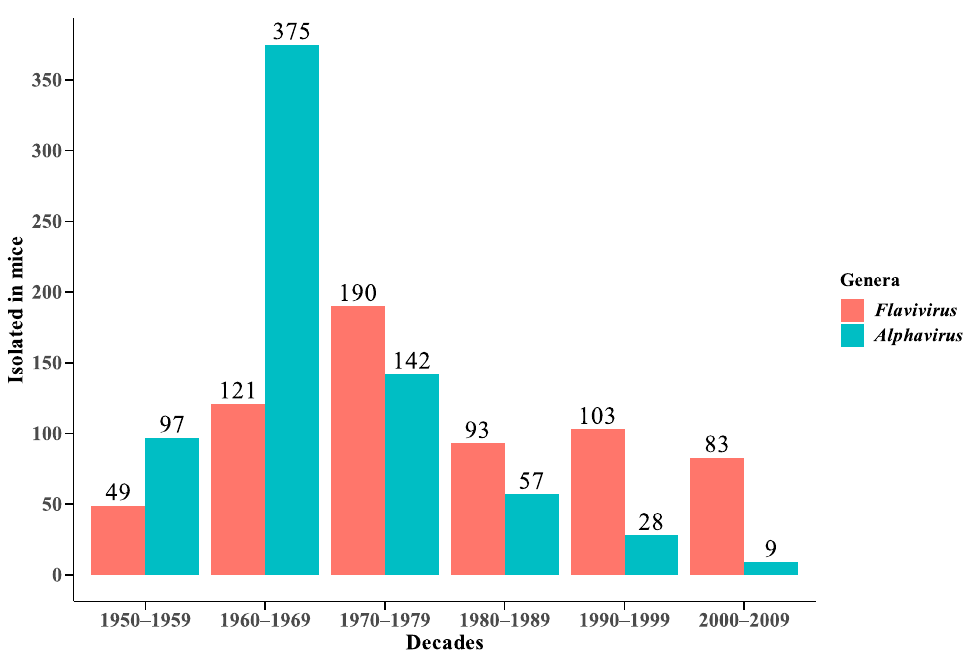
Figure 2. Distribution of Flavivirus and Alphavirus viral isolates in mice in decades from 1954 to 2009.